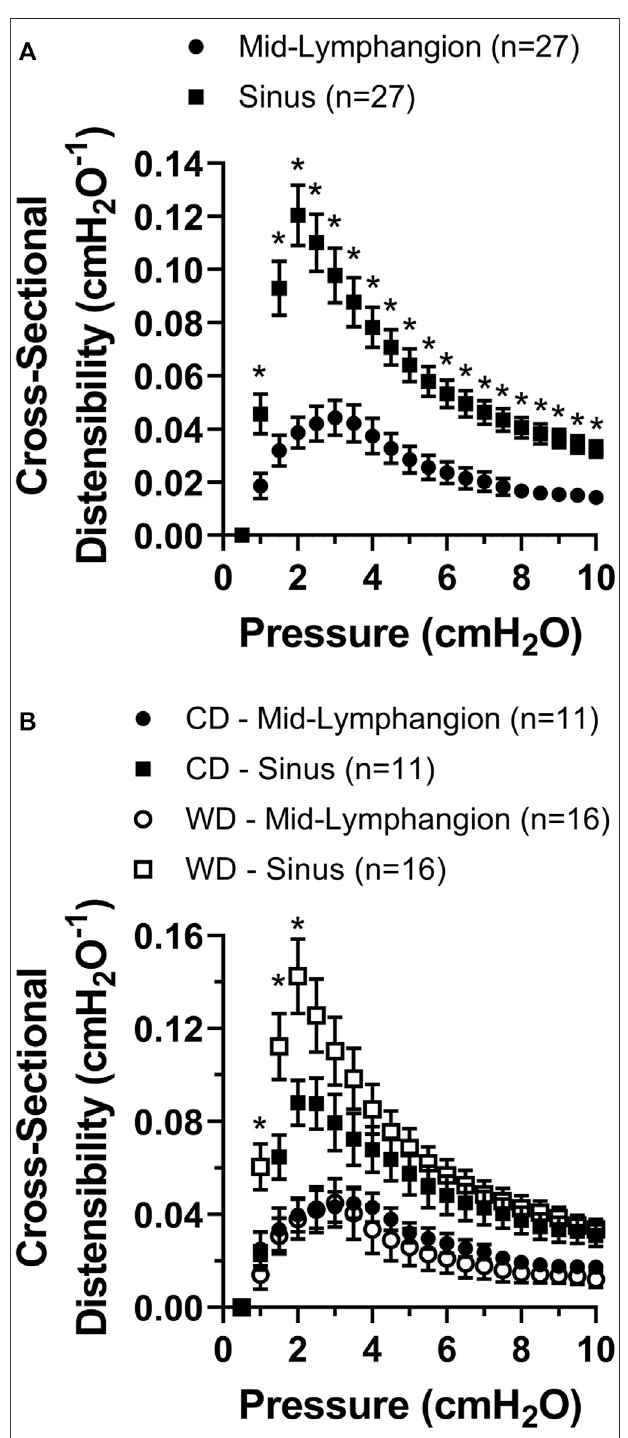
FIGURE 4 | Cross-sectional distensibility is differentially increased in the sinus areas of mesenteric lymphatic vessels and it is increased in obesity. (A) Lymphatic cross-sectional distensibility as a function of intraluminal pressure measured at mid-lymphangion and sinus areas; and (B) lymphatic cross-sectional distensibility as a function of intraluminal pressure measured at mid-lymphangion and sinus areas forspeci fi cdietgroups, i.e., CD and WD.